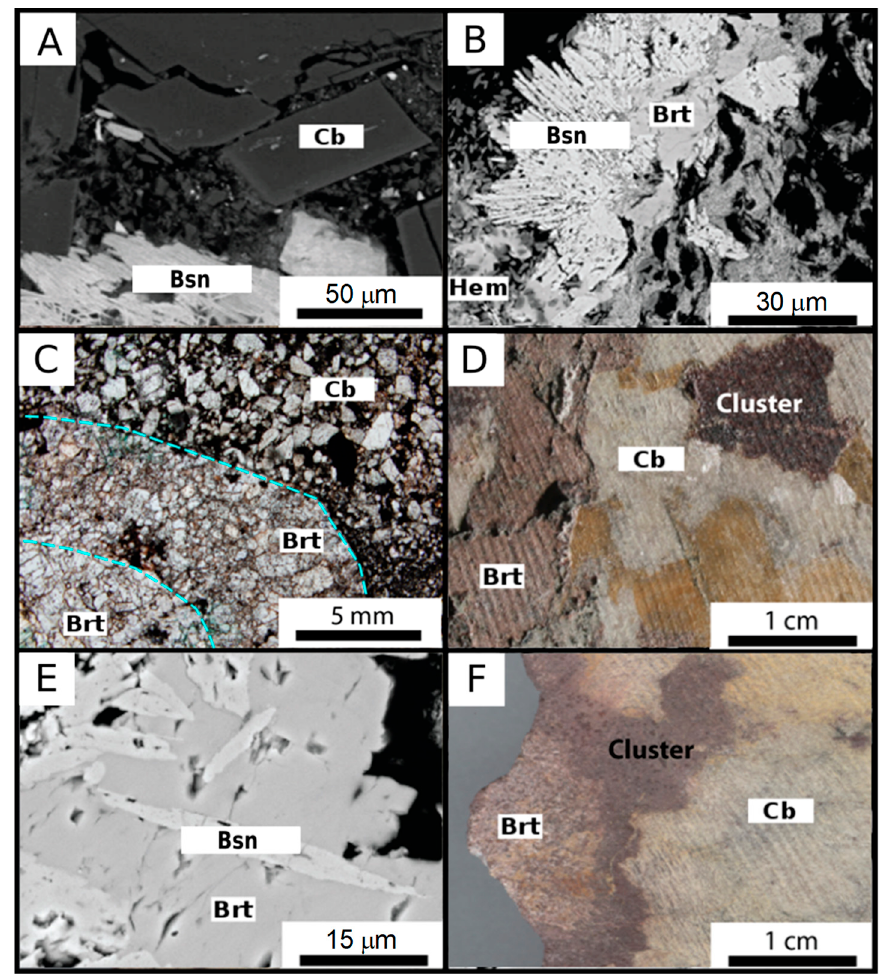
Figure 4. Selected images of the REE mineralization ordered by increasing depth: ( A ) Scanning electron microscope (SEM) image of low-intensity hydraulic breccia as suggested by the carbonate puzzle-shaped clasts (approximate depth: 235 m); ( B ) SEM image of a polycrystalline cluster showing an ameboidal shape, radial bastnäsite-(Ce), monazite-(Ce), barite, carbonate, and hematite (approximate depth: 381 m); ( C ) Photomicrograph (polarized natural light) of a large barite crystal showing a sharp pseudo-hexagonal shape (euhedral) with a pristine core, the external dashed line highlight the barite edge while the internal dashed line separate the recrystallized outer rim from the pristine core (approximate depth: 500 m); ( D ) Photograph from the recovered drill core showing REE-rich Fe-carbonatite with purple polycrystalline clusters hosting the REE minerals; the buff coloration in the lower right-hand side of the photograph appears on carbonates after a few days of exposure to air and humidity (approximate depth: 500 m); ( E ) SEM image of bastnäsite-(Ce) inclusions in a barite crystal suggesting early crystallization of REE minerals or co-crystallization of barite and bastnäsite-(Ce) (and parisite-(Ce)) (approximate depth: 910 m); ( F ) Photograph from the recovered drill core showing barite with a pristine core and an altered rim (approximate depth: 1100 m). Cb = carbonate, Brt = barite, Bsn = bastänasite-(Ce), Hem = hematite. These images are representative of all drill cores and not only the deepest one used for geochemistry.